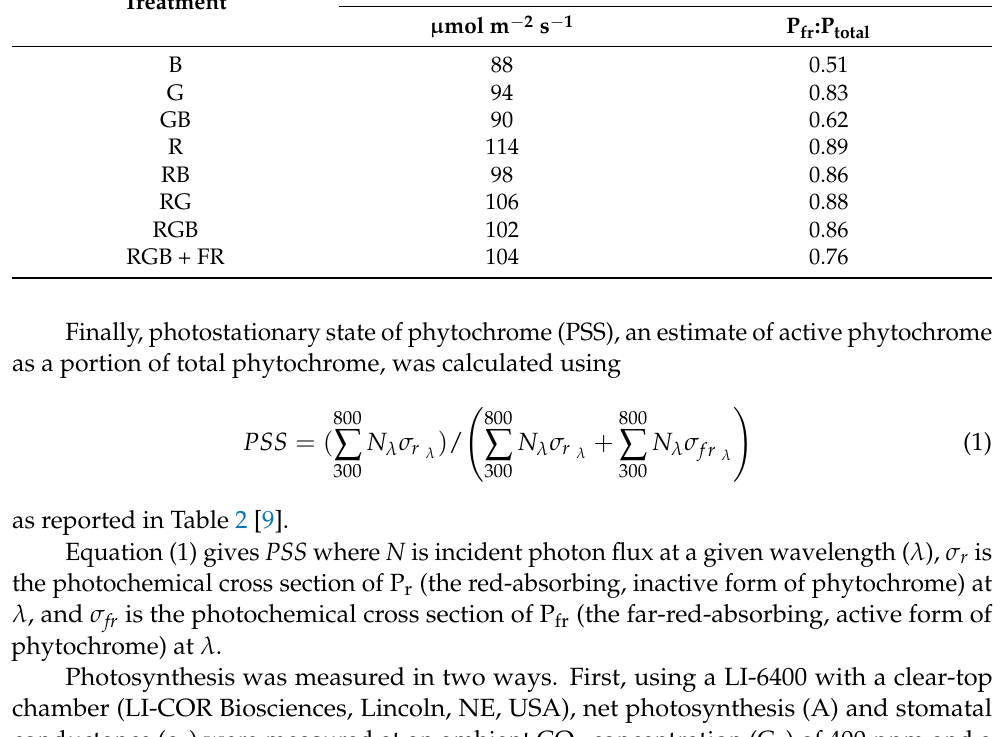
Table 5. Yield photon flux (YPF) and photostationary state of phytochrome (PSS) for each light treatment.